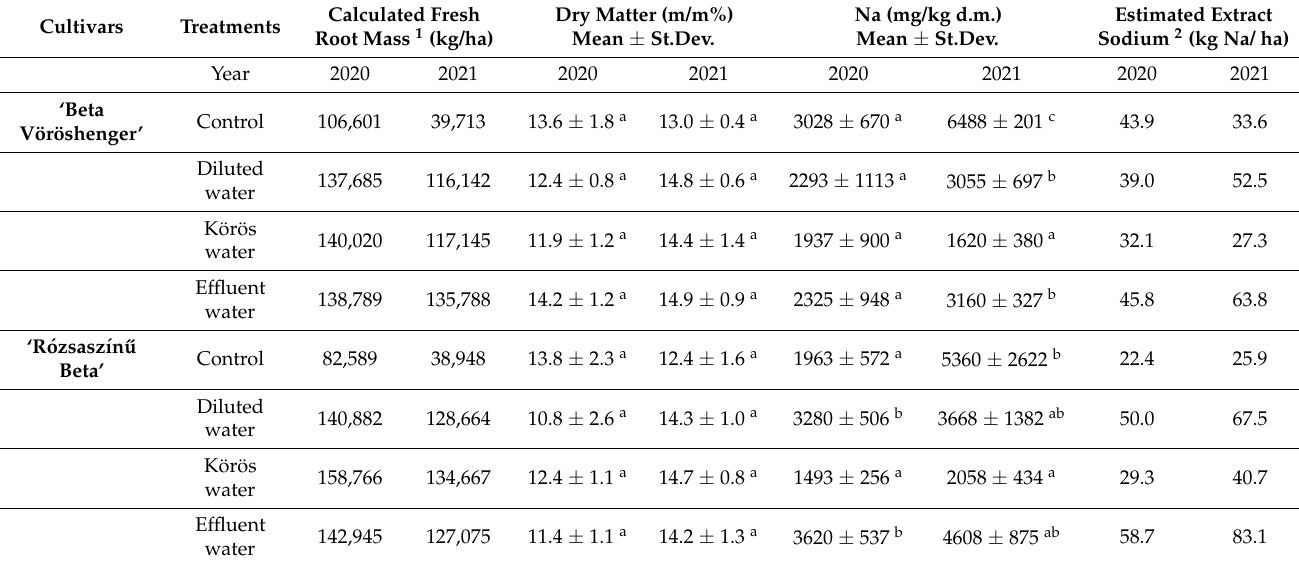
Table 3. Estimated extracted sodium by fodder beet